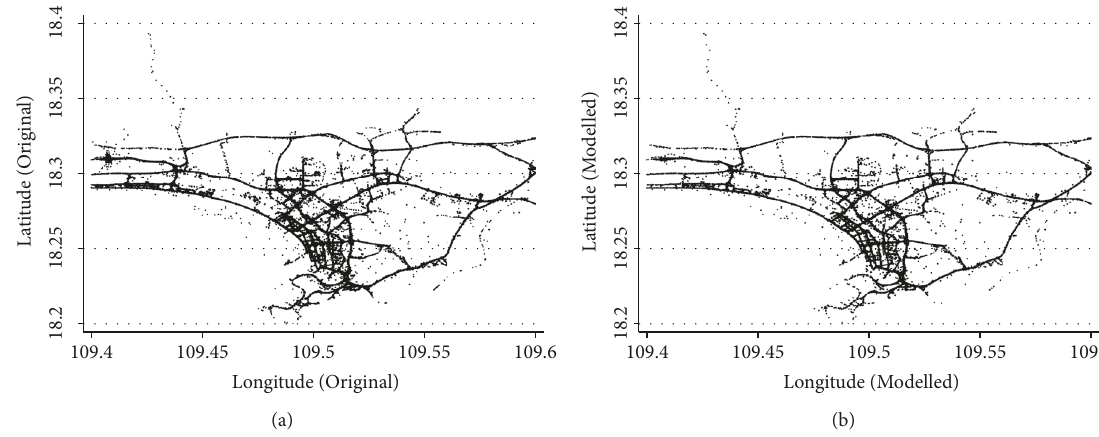
Figure 6: Path comparison of taxi positions located minutely at a fixed monitor where the longitude was in the range of [109.4 ∘ ,109.6 ∘ ] while the latitude was in the range of [18.2 ∘ ,18.4 ∘ ]. (a) Original positions. (b) Modelled positions.